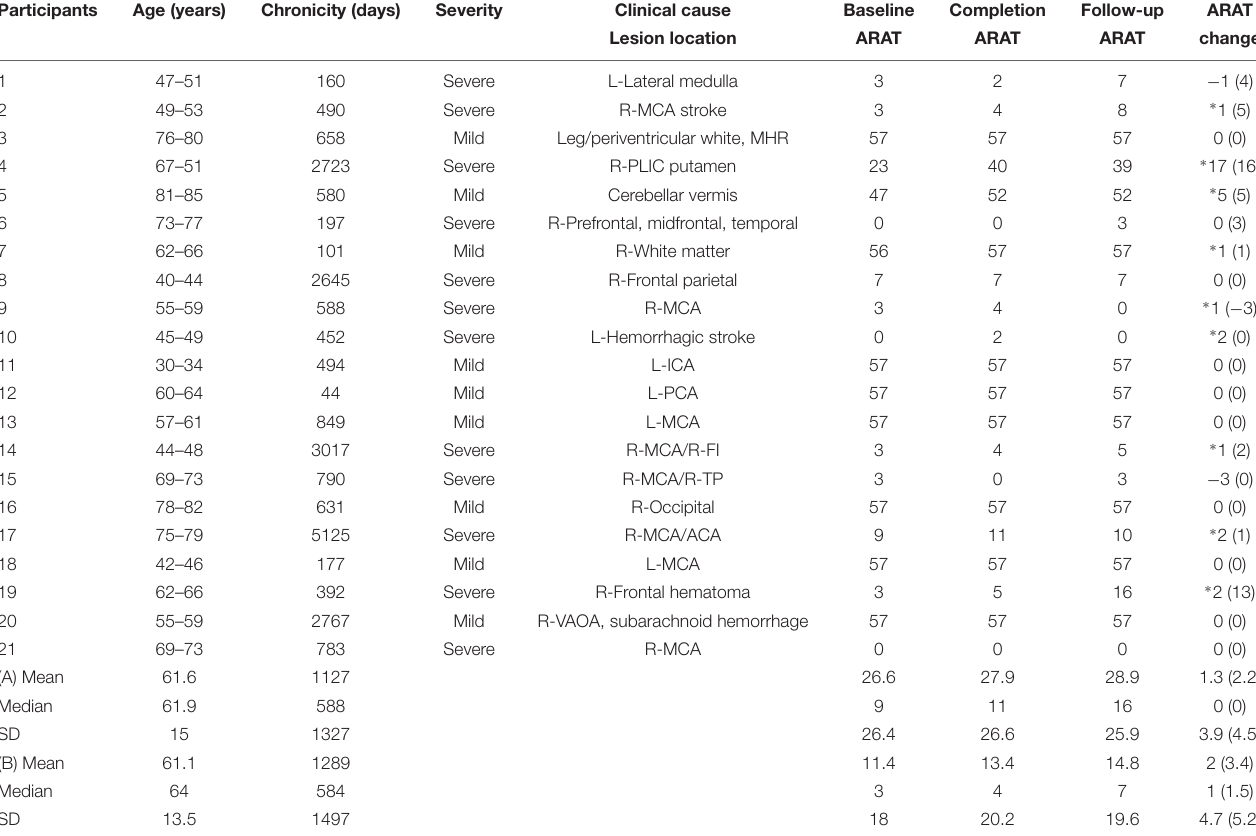
TABLE 1 | Participant characteristic and ARAT score.